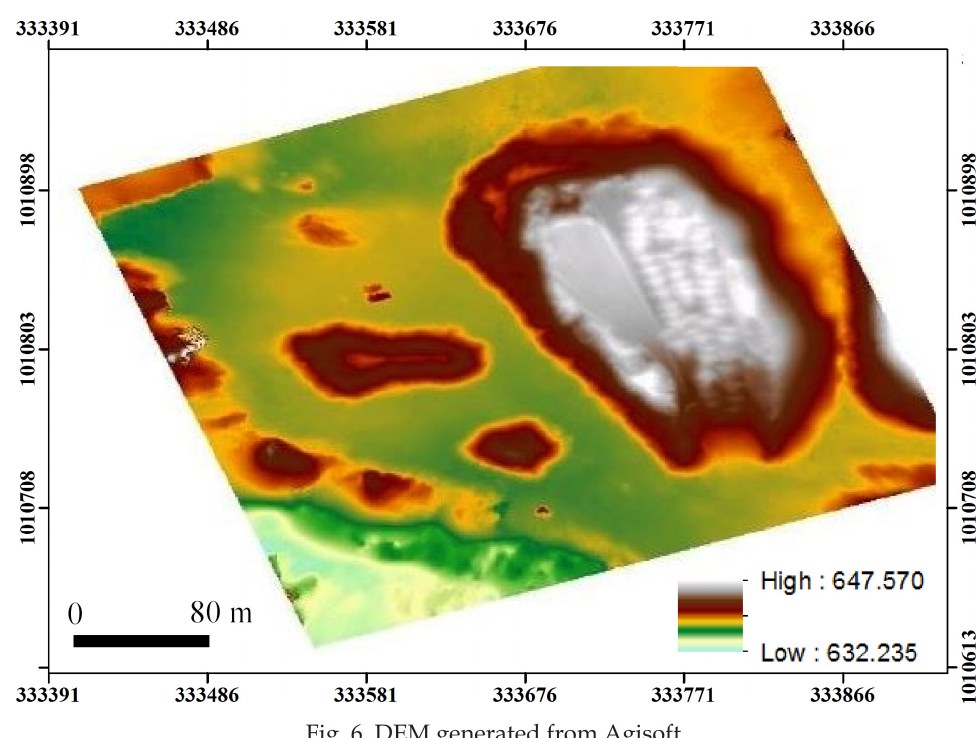
Fig. 5b. TST generated Digital Elevation Model of the stockpiles.